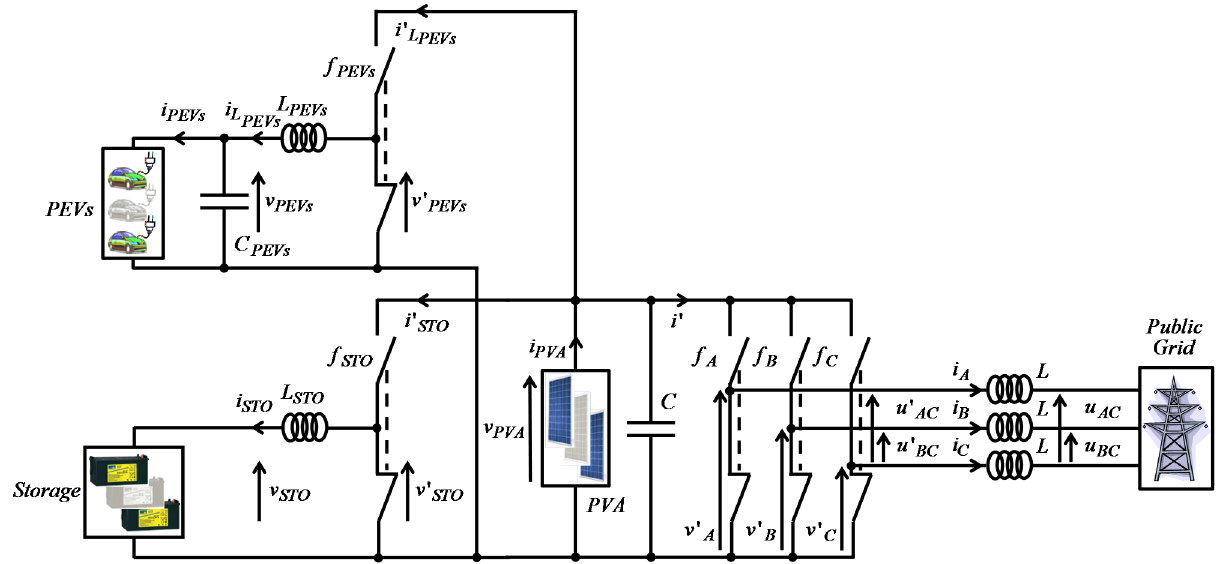
Figure 2. Electrical scheme of the DC microgrid power